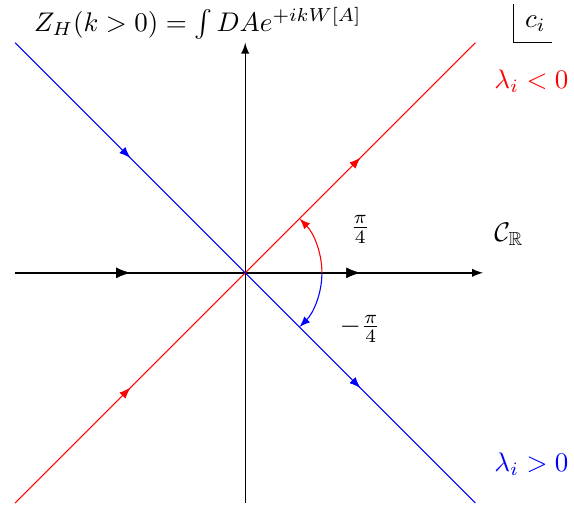
Figure 1 . Steepest Descent Paths of the L